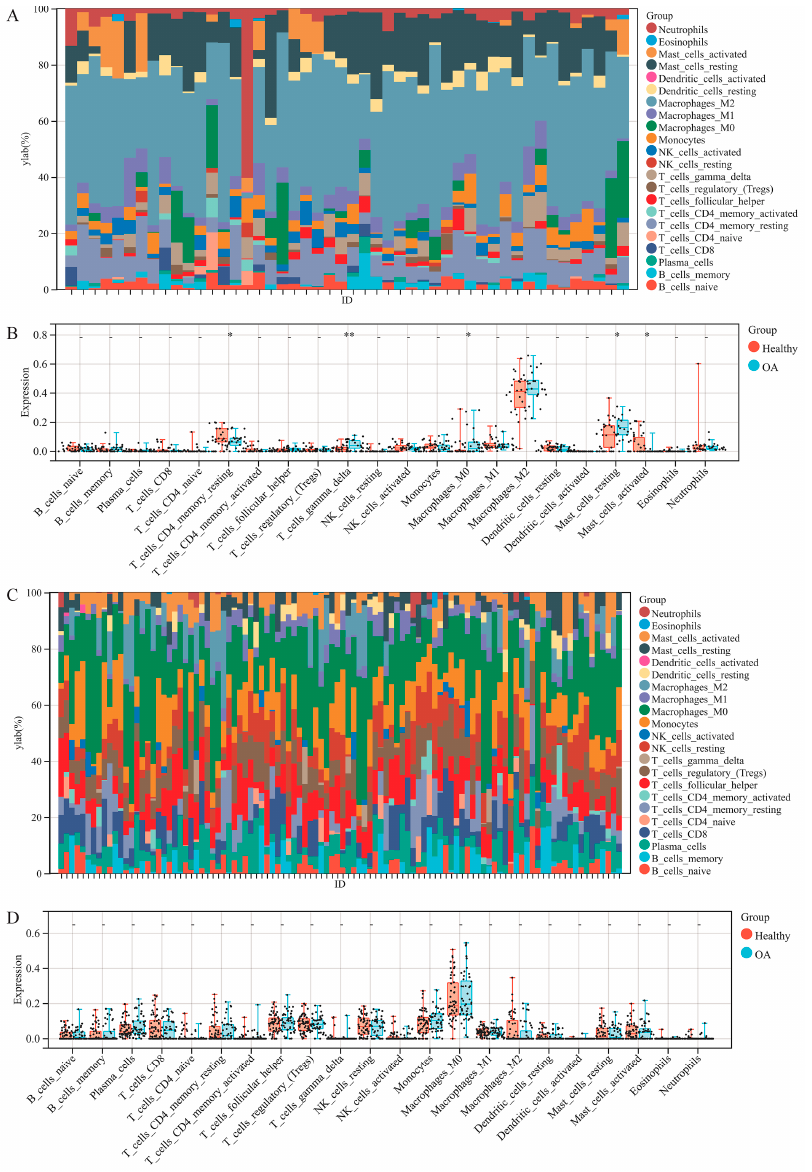
Figure 3. CIBERSORT immune cell infiltration analysis. Stack diagram of immune cells in the synovium dataset, ( A ). Box and scatter plot of the synovium dataset, ( B ). Stack diagram of immune cells in the cartilage dataset, ( C ). Box and scatter plot of the cartilage dataset, ( D ).